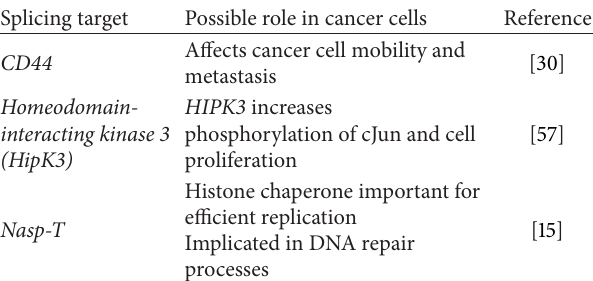
Table 2: Known pro-oncogenic splicing targets of Tra2 𝛽